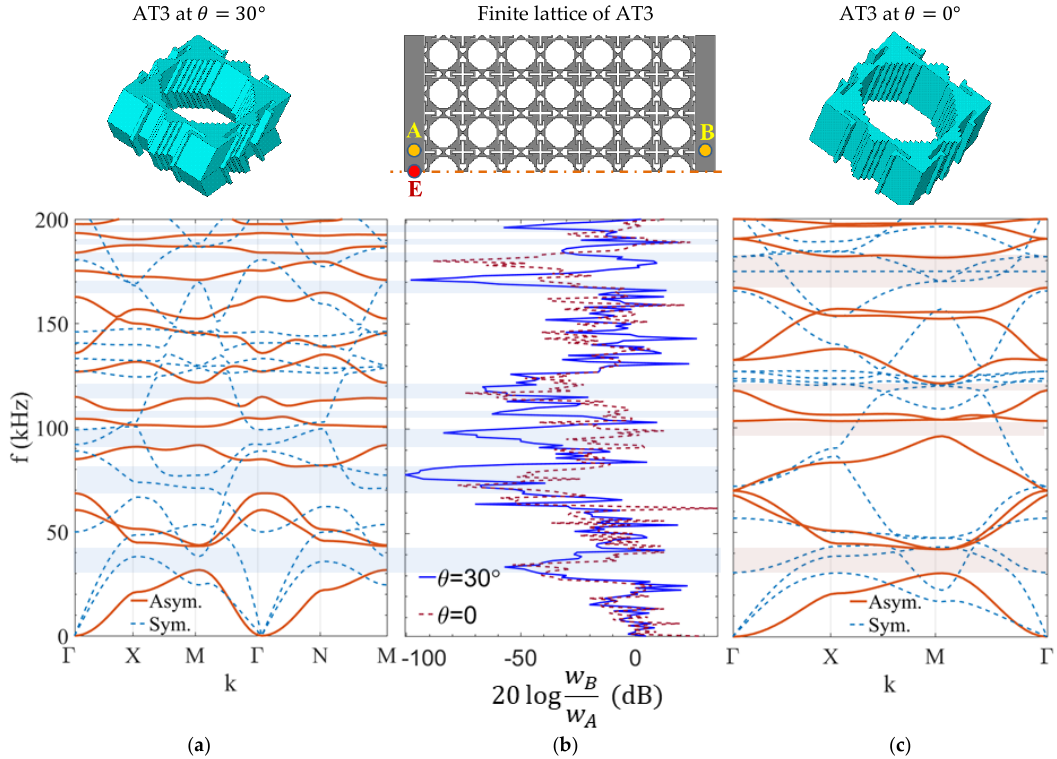
Figure 7. Modal band structure of S-OPhP of topology AT3 at perforation angles ( a ) 30° and ( c ) 0° , and ( b ) transmission spectrum in a finite phononic structure for both perforation angles.